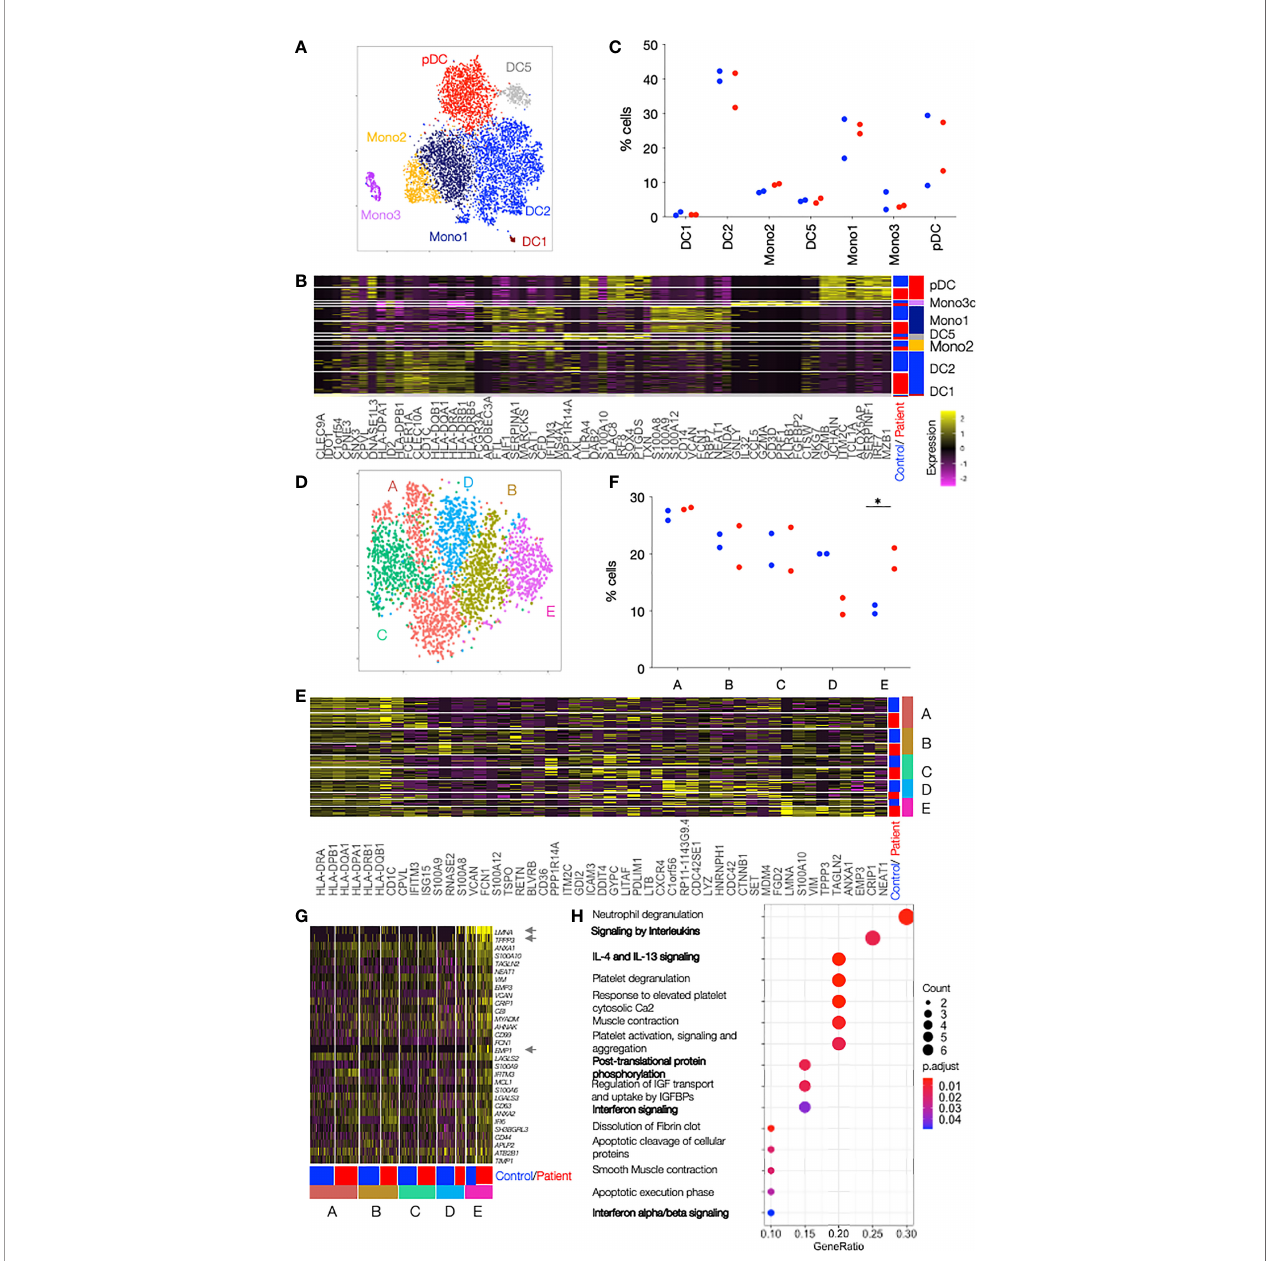
FIGURE 2 | Single cell RNAseq reveals clusters enriched in patient cells. (A) DCs and Monocytes isolated from blood of 2 patients with TREX1 mutation and 2 controls were analyzed by single cell RNaseq. tSNE of all sequenced cells after clustering into 7 clusters separates the cells into the 7 cell types annotated and color coded. (B) Heat map showing the top 10 cluster markers for each of the cell types. The row color bar on the right shows the color codes (as in A) for the cell types, and the bar on the left shows in blue cells from controls and in red cells from patients. Graduation of expression ranges from purple (absent) to yellow (high). (C) Dot plot showing the proportion of patients or control cells found in each cluster. Patients are shown in red and controls in blue. (D) tSNE of DC2 cells from 2 patients and controls after clustering into 5 subclusters. (E) Heat map showing the top 10 cluster markers for each DC2 subcluster. The row color bar on the right shows the color codes for the subclusters (A – E) (as in D), and the bar on the left shows in blue cells from controls and in red cells from patients. (F) Dot plot showing the proportion of patients or control cells found in each DC2 subcluster. Patients are shown in red and controls in blue. (G) Heat map showing all DC2-E marker genes in cells from all DC2 subclusters (A-E) in controls and patients. All genes belong to the Type I Interferon response according to Interferome. Asterisks point to genes whose expression is almost unique in DC2-E. The row color bar on the right shows the color codes for the subclusters (A – E) and the bar on the left shows in blue the cells from controls and in red the cells from patients. (H) Dotplot showing the signi fi cance of the pathways enriched in cluster DC2-E (ReactomePA). Pathways with relevance for the DCs are in bold. Count is the number of genes involved in the pathway. Gene Ratio is the ratio of the genes involved in each pathway to the total number of cluster genes. P adjust is the adjusted p-value. Comparisons with signi fi cance are marked with an *(p-value< 0.05, Mann-Whitney